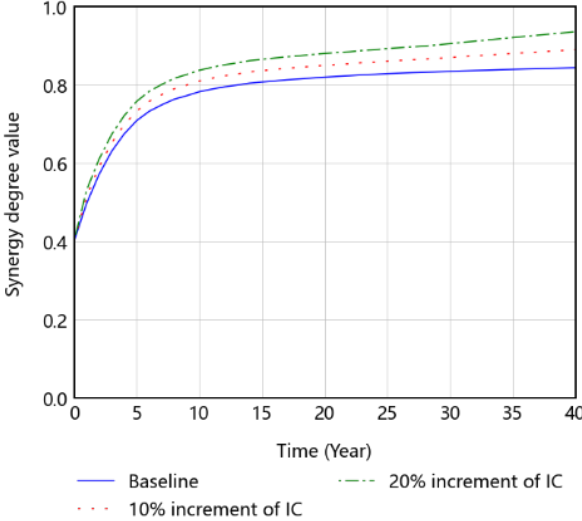
Figure 12. The effects of different degrees of IC on synergy.